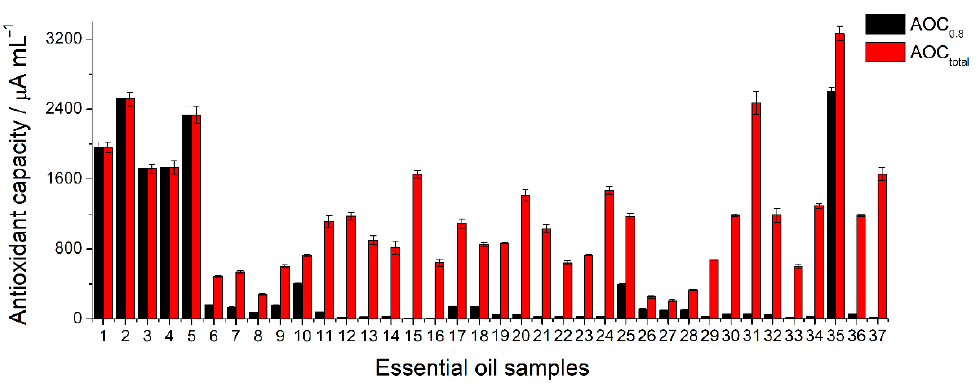
Figure 2. Antioxidant capacity of the essential oils based on chronoamperometric data. Samples 1–